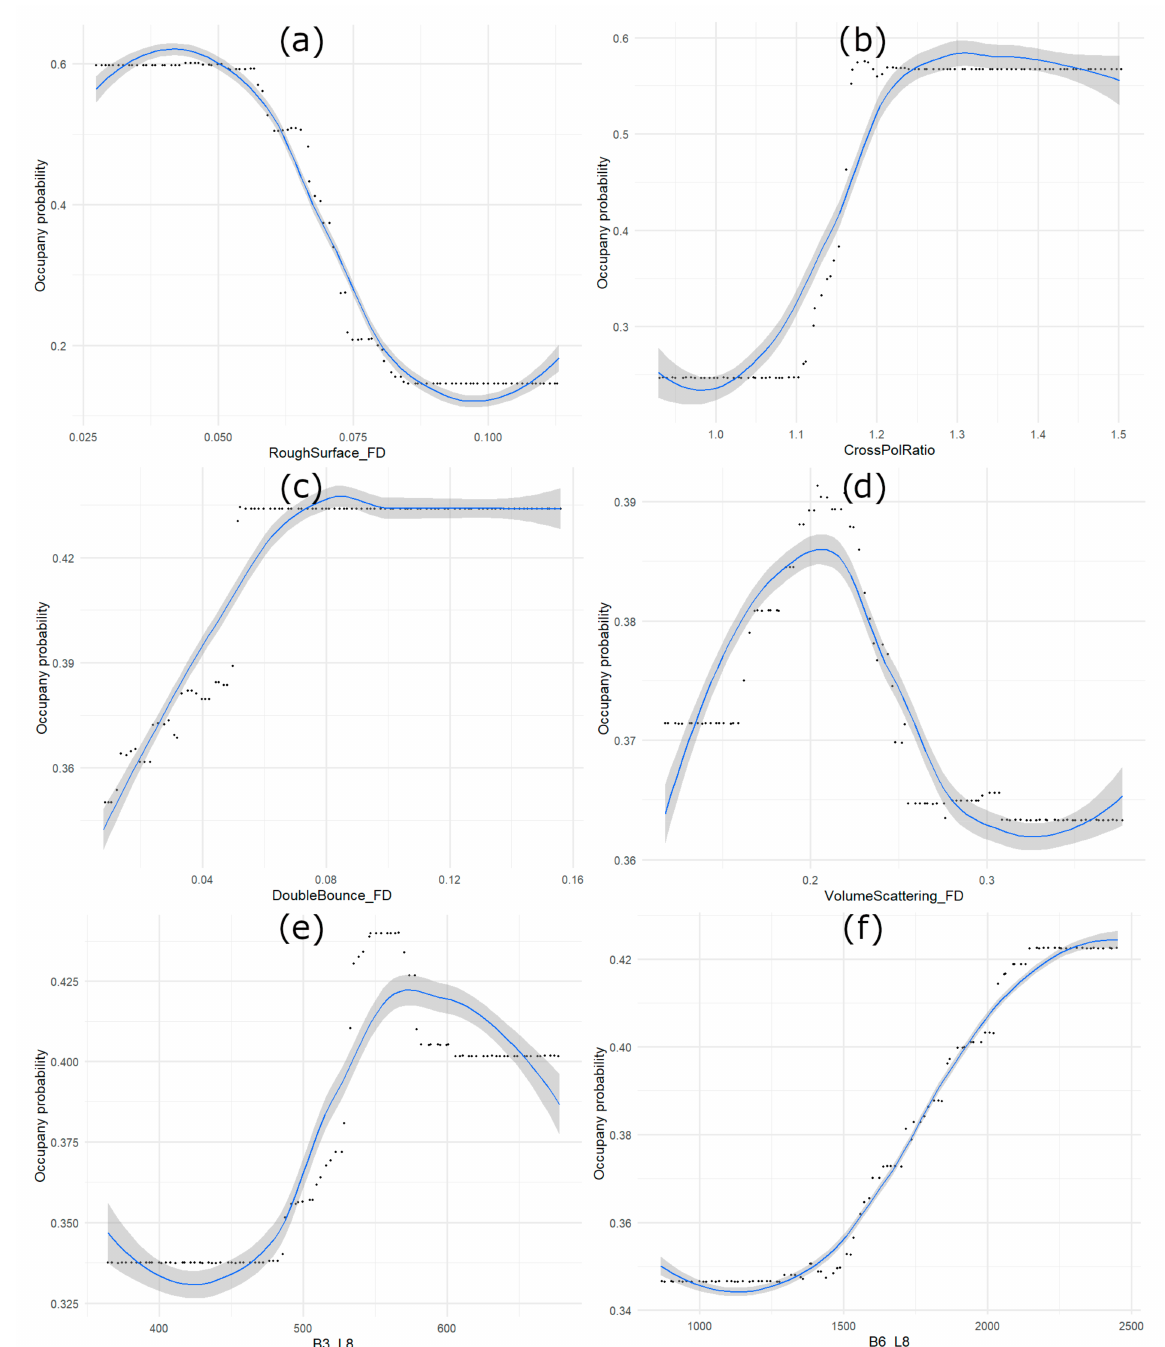
Figure 4. Response plots (how occupancy probability changes with changing EO values) for six potential YERA model inputs. ( a ) Rough surface ( b ) cross polarization ratio, ( c ) double bounce, ( d ) volume scattering, ( e ) band 3, ( f ) band